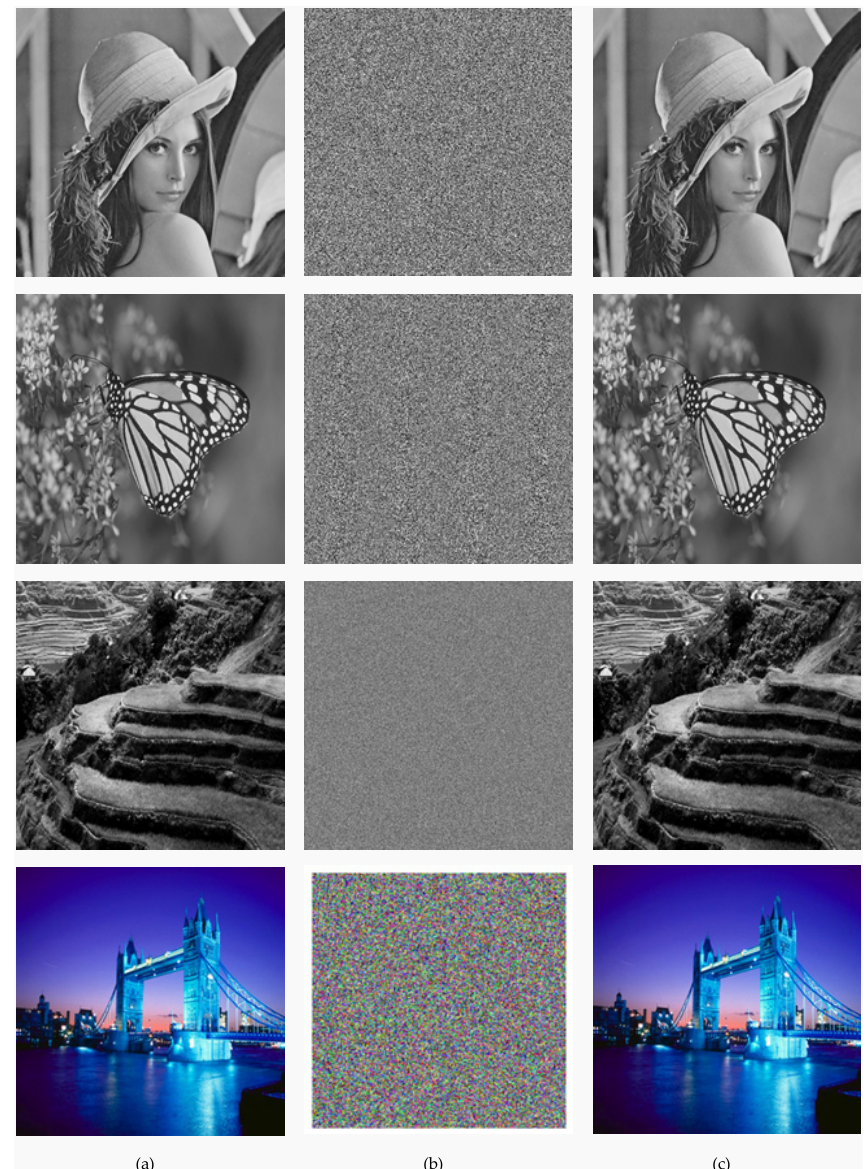
Figure 5. Encryption and decryption results: ( a ) plain images; ( b ) cipher images; ( c ) decrypted im- ages.